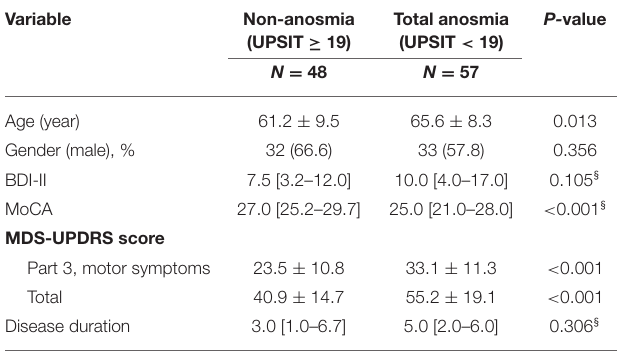
TABLE 1 | Clinical characteristics of PD patients grouping with UPSIT cut-off of 19. Variable